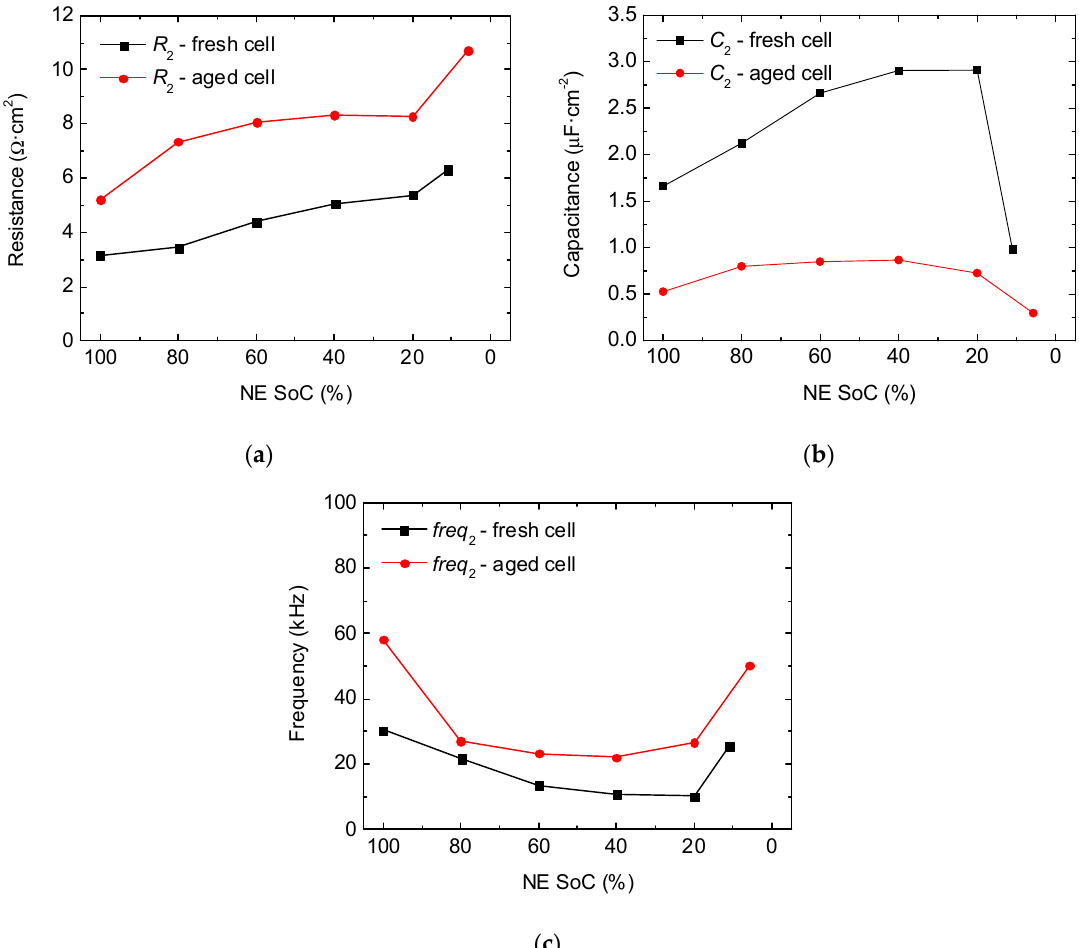
Figure 3. ( a ) Resistance, ( b ) capacitance, and ( c ) characteristic frequency related to P2_NE measured at the graphite/Li half-cell at 25 °C. This effect has been attributed to the current–collector interface.